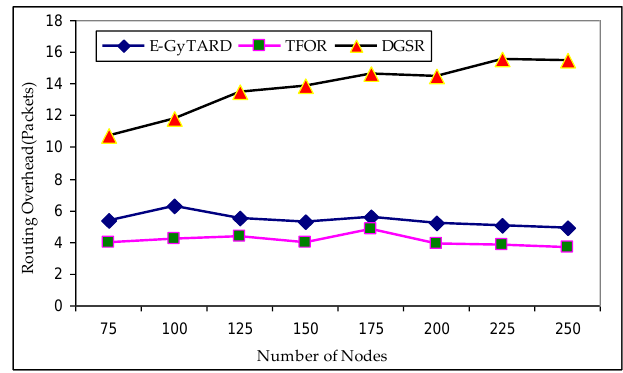
Figure 12. Routing overhead vs. the number of nodes (@5 packets/s).